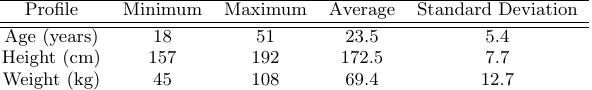
Table 1: Subject body profile summary